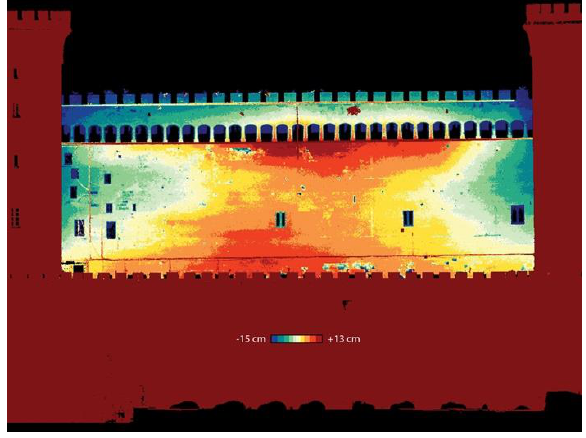
Figure 15. False color chart of the geometric deformation of the flat wall between the Guard and the Golden towers.